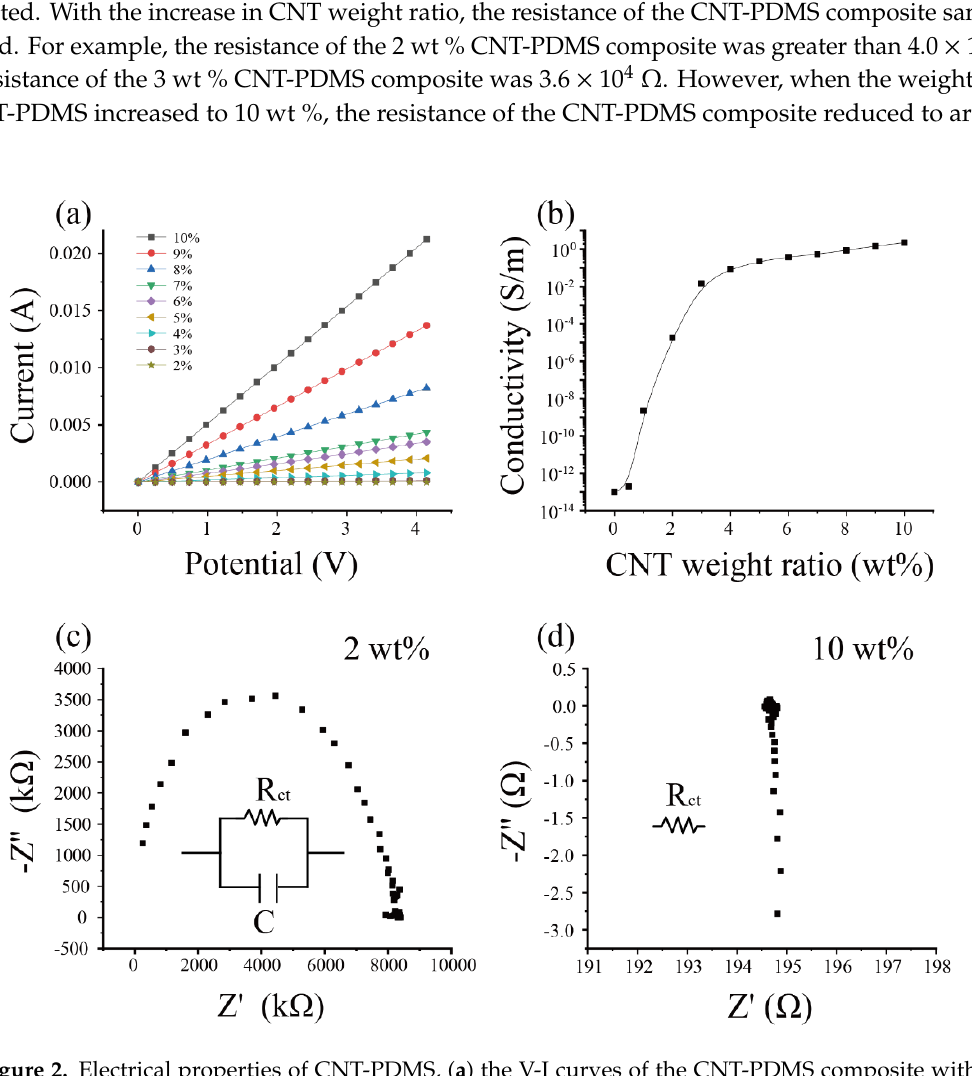
Figure 2. Electrical properties of CNT-PDMS, ( a ) the V-I curves of the CNT-PDMS composite with di ff erent weight ratios (wt %), ( b ) the relationship between the electrical conductivity of the CNT-PDMS composite with di ff erent weight ratios, ( c ) the impedance analysis of the 2 wt % CNT-PDMS composite and its equivalent circuit model, ( d ) the impedance analysis of the 10 wt % CNT-PDMS composite and its equivalent circuit model.